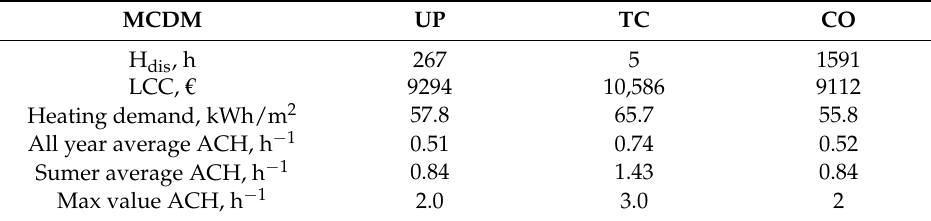
Table 6. Optimal results for case 3.